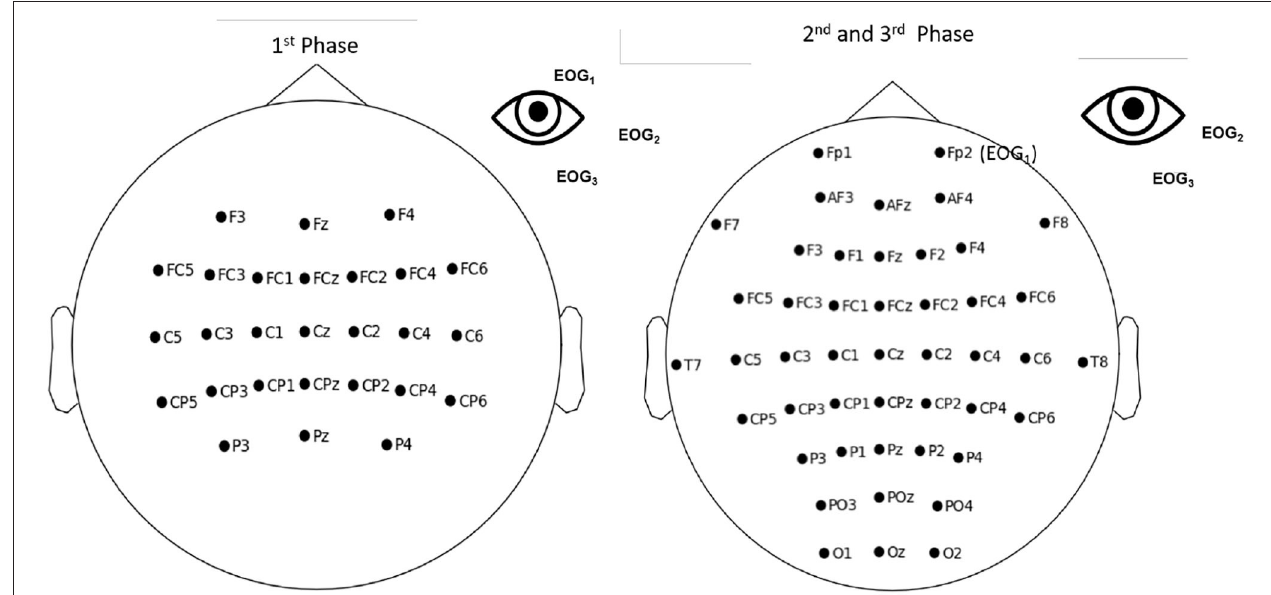
FIGURE 2 | Electrodes used during the first (exploratory) phase (left) , and the second (2-class training) and third (transfer) phases of the training (right) . For all the phases we used the same EEG hardware g.USBAmp (g.tec, Austria), sampled at 512 Hz) but we added more electrodes (16) for the second and third